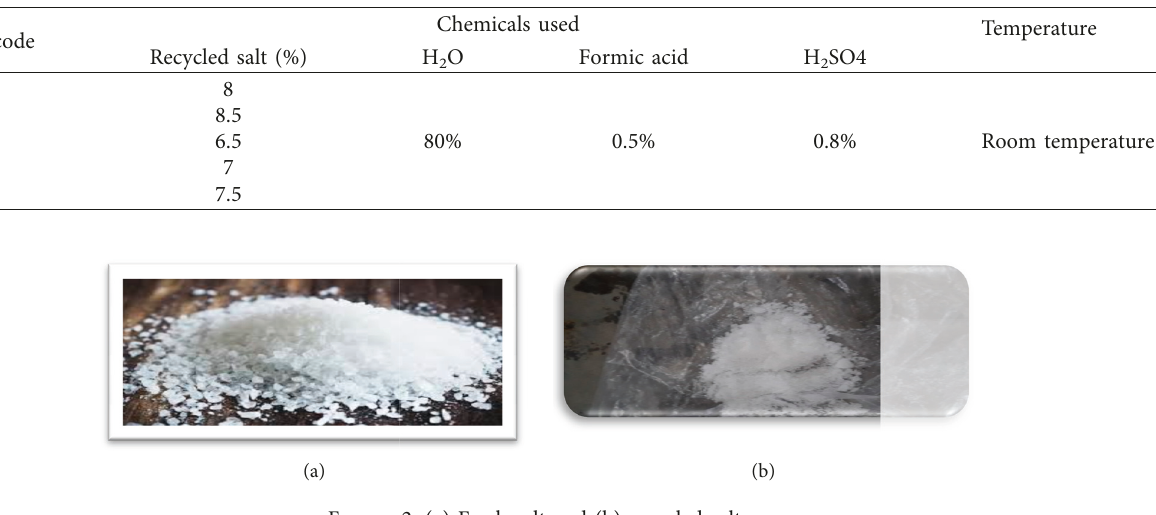
Figure 2: (a) Fresh salt and (b) recycled